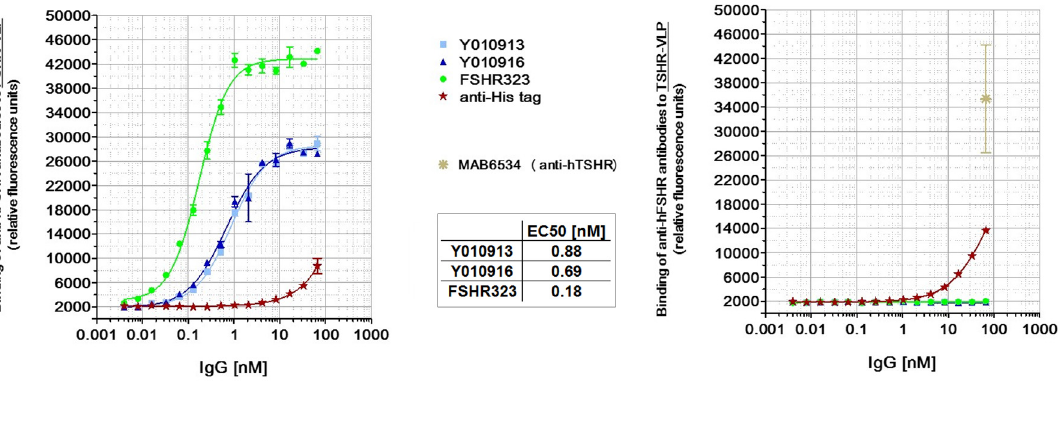
Figure 3. Specificity assessment of anti-FSHR antibodies using Virus-like particles containing FSHR in ELISA. VLPs containing the FSHR protein ( A ) or TSHR protein ( B ) used as control were coated on Maxisorp plates. FSHR was detected with different concentrations of Y010913, Y010916, and FSHR323. The mouse monoclonal anti-hTSHR antibody 6534 (R&D Systems) was used to detect VLPs containing hTSHR protein. The mouse monoclonal anti-His tag antibody was used as an irrelevant antibody.